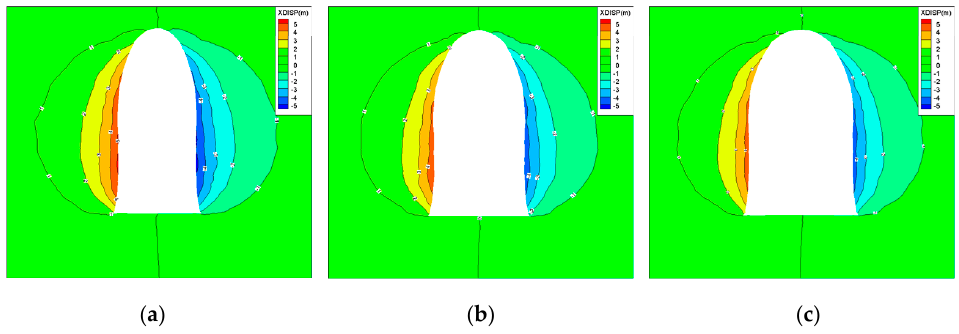
17 of 25 Figure 13. Z ‐ displacement of cavern roof with different well spacings at different operating times. Figure 14 presents the displacement contours in the X direction with different well spacings after operating for 30 years under an internal gas pressure of 14 MPa. Figure 15 shows the X ‐ displacement curves of the cavern waist with different well spacings at dif ‐ ferent times. The X direction of the 3D geomechanical model is in the long axis direction of the cavern, and the Y direction is in the short axis direction of the cavern. It can be seen that the Y ‐ displacement of the waist (Figure 16) increases with the well spacing, but the X ‐ displacement of the waist has an opposite tendency. A similar phenomenon was also observed in the stability study of SSTW salt cavern gas storage in a shallow formation in [35]. After 30 years of operation, the displacement in the Y direction is 5.55 m, 5.84 m and 6.01 m, respectively, when the well spacing varies from 10 to 30 m. As the well spacing increases, the transverse section of the cavern becomes flatter, and more loads are applied